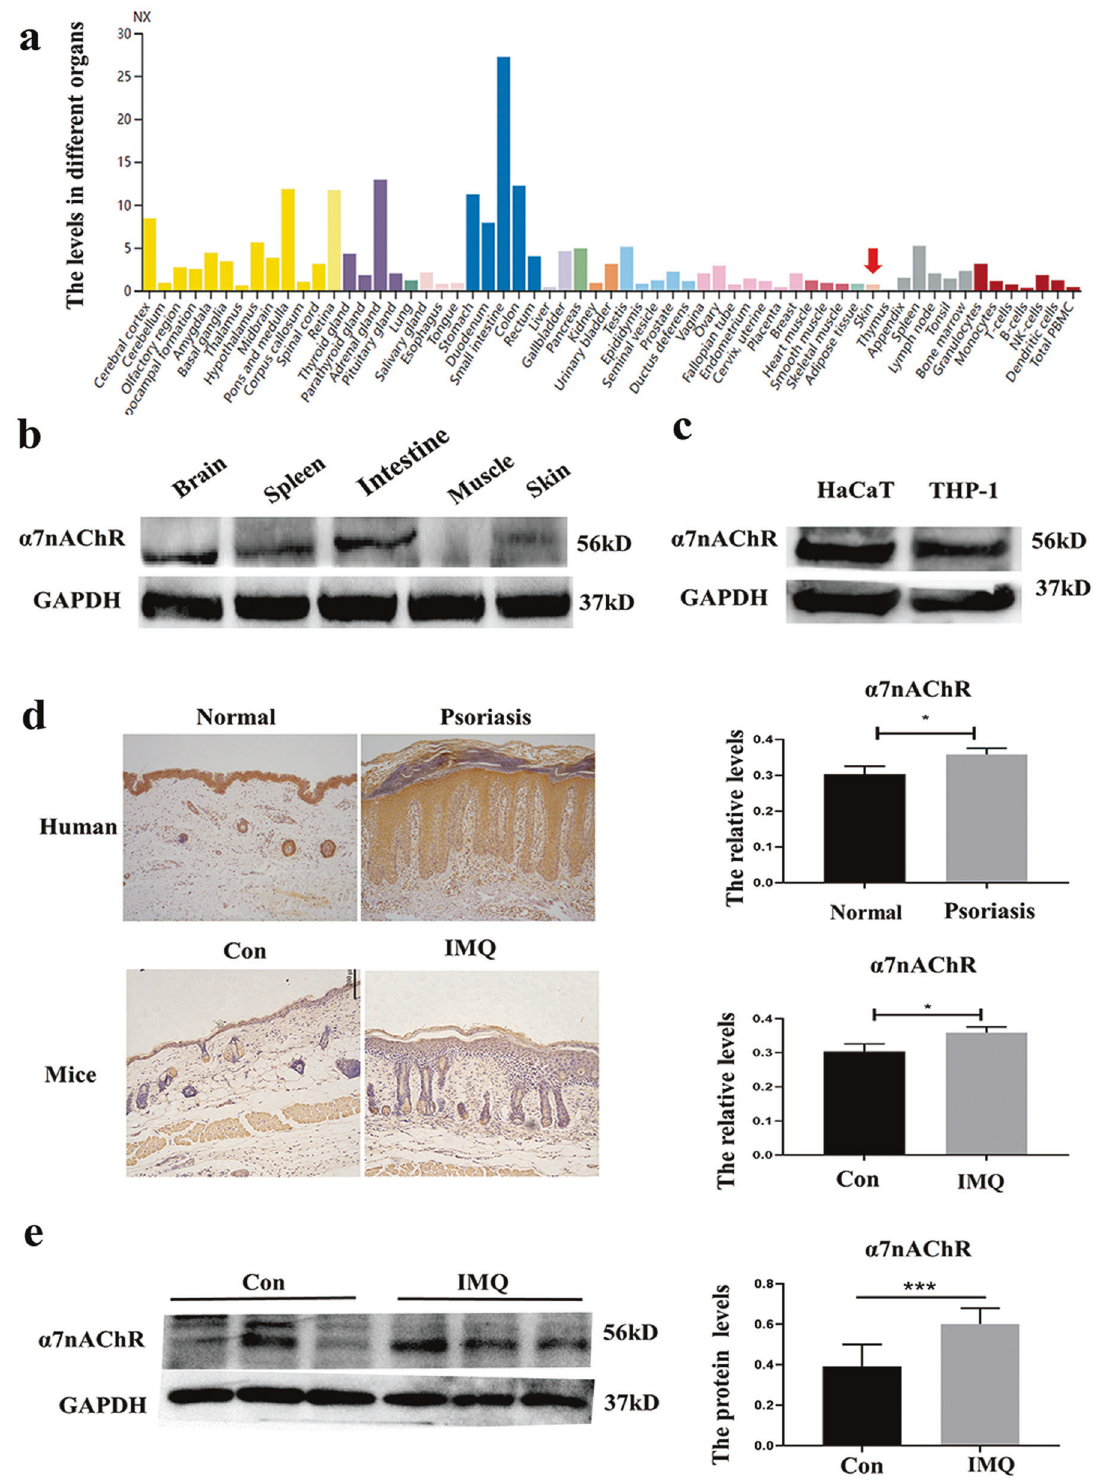
Fig. 1 Increased expression of α 7 nicotinic acetylcholine receptor was detected in the human and mouse psoriatic lesional skin tissue. A The protein and mRNA of α 7nAChR were expressed in skin tissue (arrows) from the Human Protein Atlas website. The red arrow indicates the levels of α 7nAChR in skin tissue. Upper panel: protein levels, lower panel: mRNA levels. B Immunohistochemical staining indicated that α 7nAChR was distributed throughout the human epidermis of skin from a healthy individual and psoriasis patient (magni fi cation ×100). C Western Blot assay con fi rmed the expression of α 7nAChR in HaCaT cells compared to THP-1 cells. D Immunohistochemical staining of α 7nAChR in skin from control group and IMQ-induced model group (magni fi cation ×100; n = 6). E Analysis of the expression levels of α 7nAChR protein in different organs, including brain, spleen, intestine, muscle, and skin from BALB/c mice. GAPDH was used as the internal